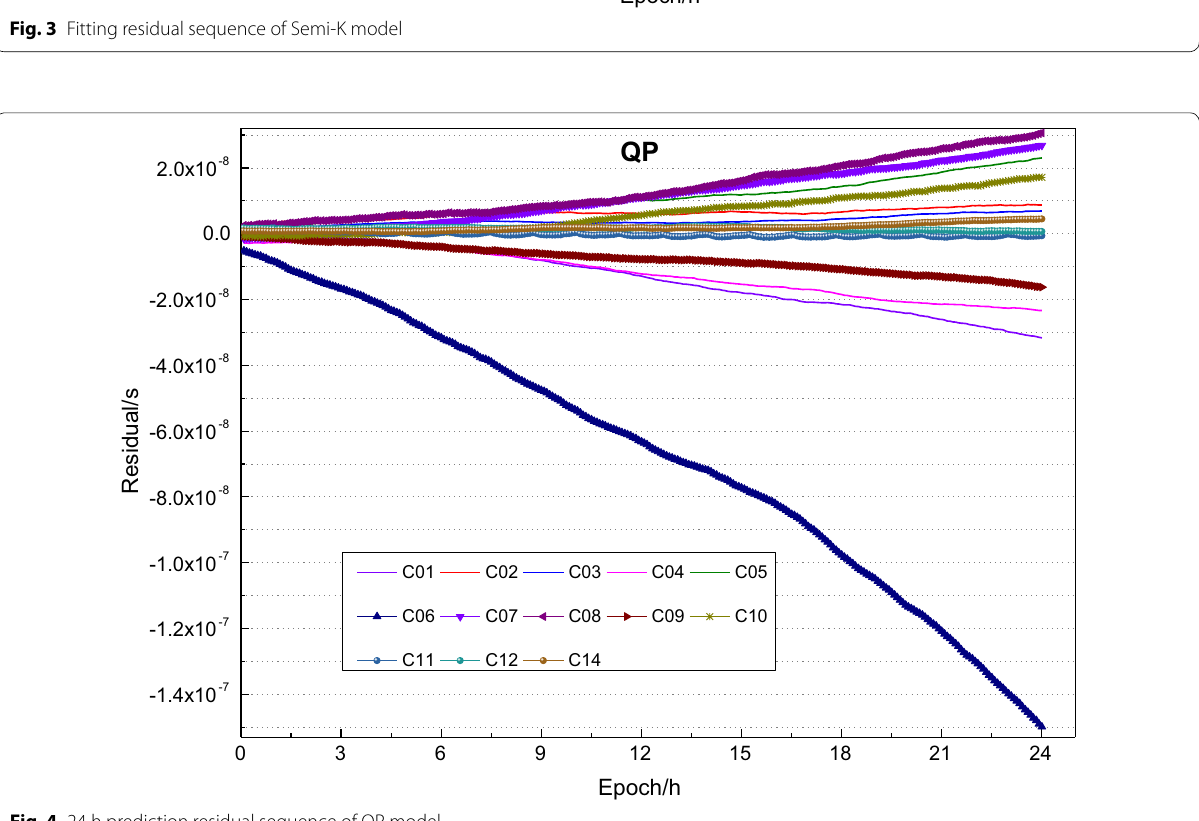
Fig. 4 24 h prediction residual sequence of QP